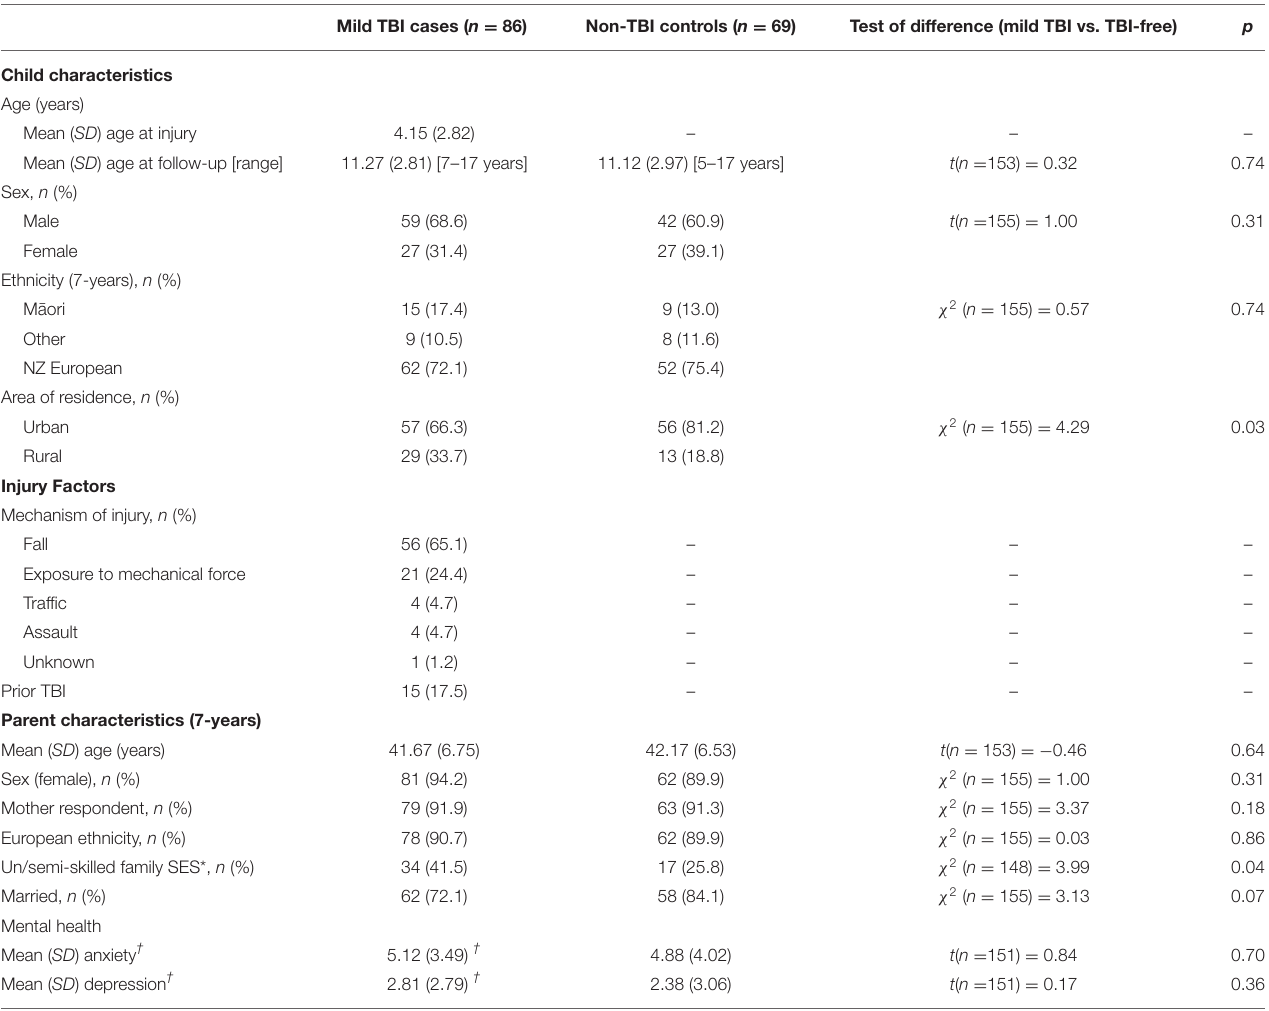
TABLE 1 | Sample characteristics for mild TBI cases and non-TBI controls. Mild TBI cases ( n =